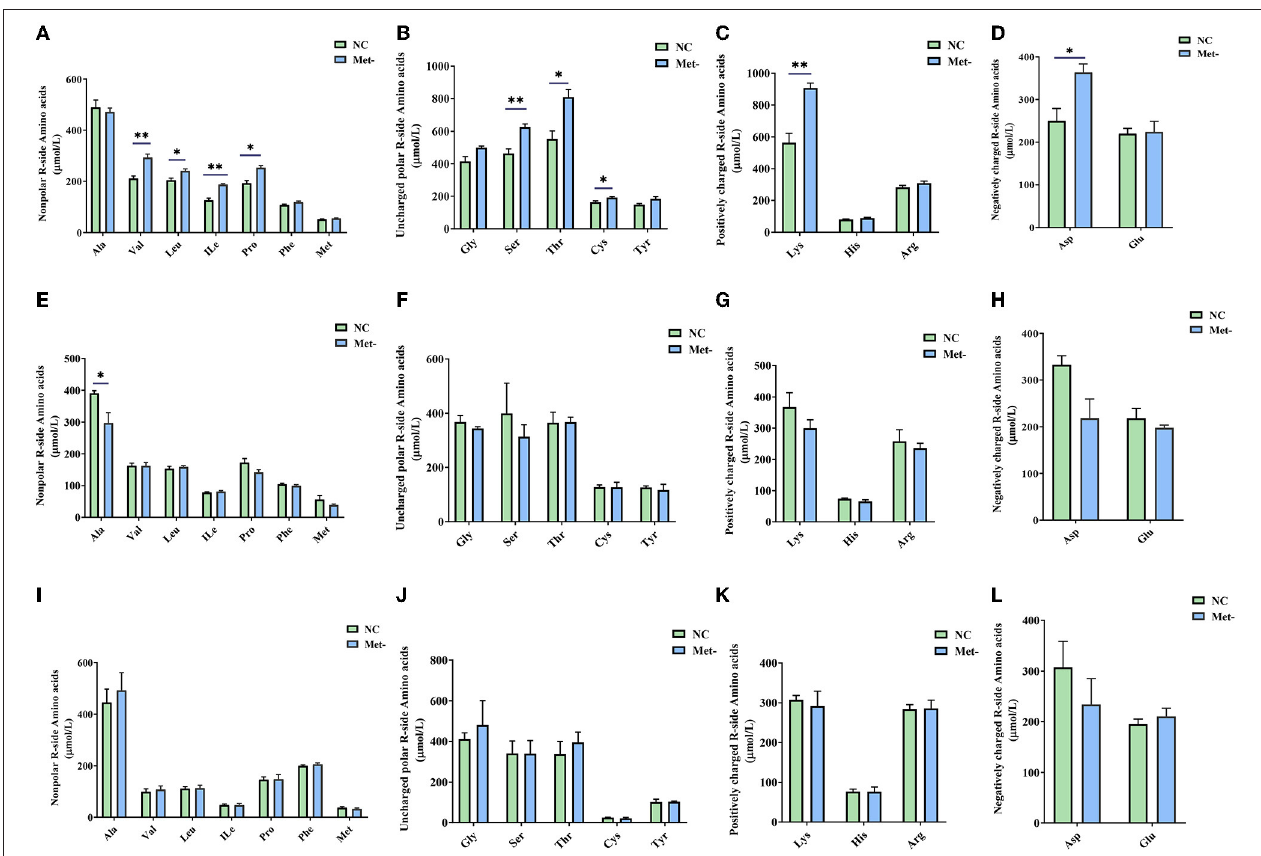
FIGURE 2 | Effects of Met deficiency in rearing period diets on serum concentration of amino acids (AA) of laying hens. (A–D) serum concentration of amino acids (AA) of laying hens at 6th weeks, (A) Nonpolar R-side Amino acids. (B) Uncharged polar R-side Amino acids. (C) Positively charged R-side Amino acids. (D) Negatively charged R-side Amino acids. (E–H) serum concentration of amino acids (AA) of laying hens at 16th weeks. (E) Nonpolar R-side Amino acids. (F) Uncharged polar R-side Amino acids. (G) Positively charged R-side Amino acids. (H) Negatively charged R-side Amino acids. (I–L) serum concentration of amino acids (AA) of laying hens at 24th weeks. (I) Nonpolar R-side Amino acids. (J) Uncharged polar R-side Amino acids. (K) Positively charged R-side Amino acids. (L) Negatively charged R-side Amino acids. Data were presented as means ± SEM. Significant differences were tested by student’s t -test. *Indicates significant difference, P < 0.05; **, P <